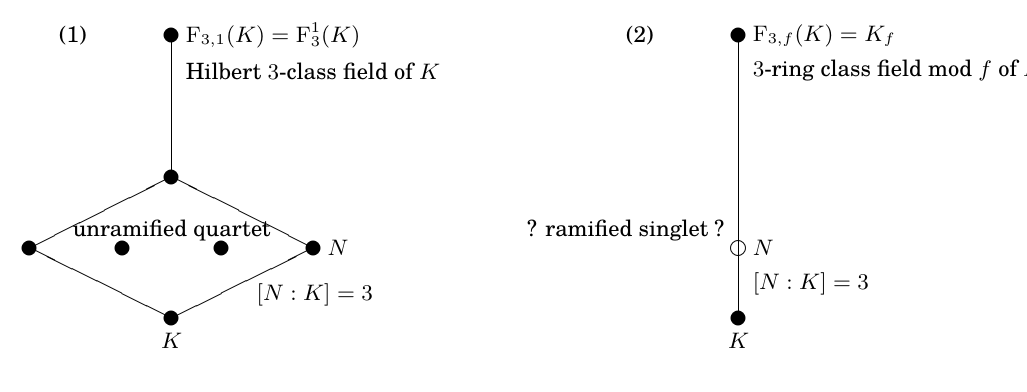
Figure 6: Hilbert and ring class fields over K